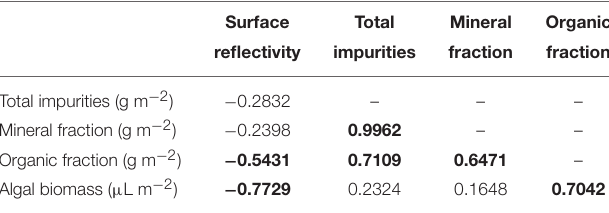
TABLE 2 | Pearson’s correlation coefficients ( r ) among surface reflectivity, mass abundances of total and each fraction of impurities, and algal biomass on the ice surface of Glacier No.